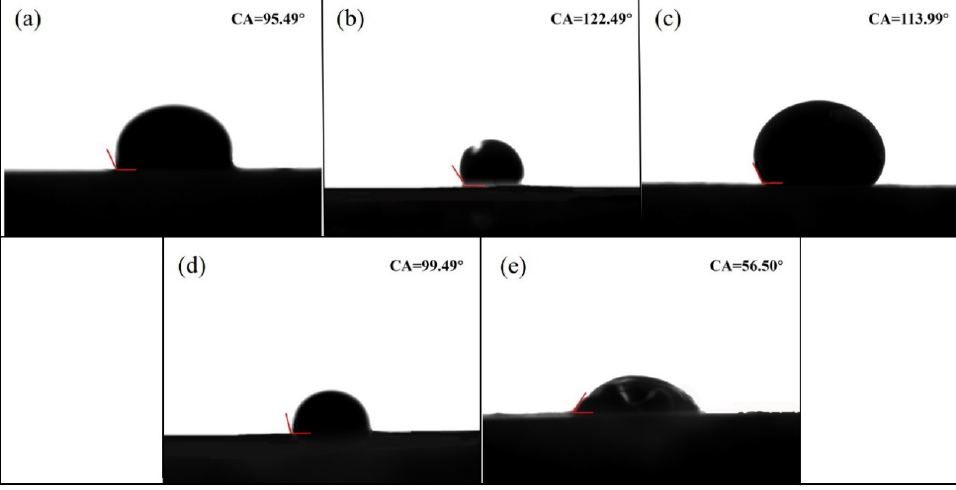
Figure 10. Contact angle of water with aggregates: ( a ) limestone; ( b ) diorite; ( c ) diabase; ( d ) SSA; ( e ) PSSA. Table 6. Surface free energy of bitumen and probe liquid (mJ/m 2 ). Reagent